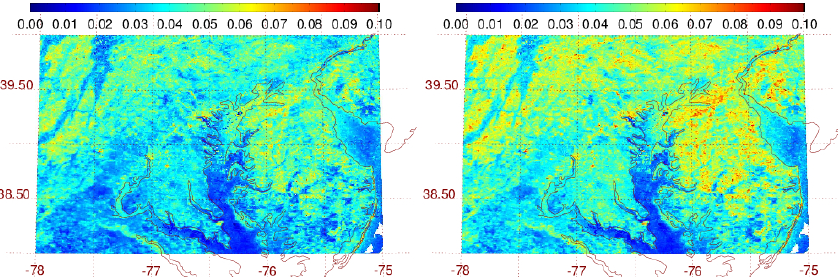
Figure 1. High spatial resolution MODIS-based LERs for the Baltimore–Washington area of the United States for 17 (left) and 18 (right) January 2005 computed with the original spatial resolution of 30arcsec but for OMI observational geometries.